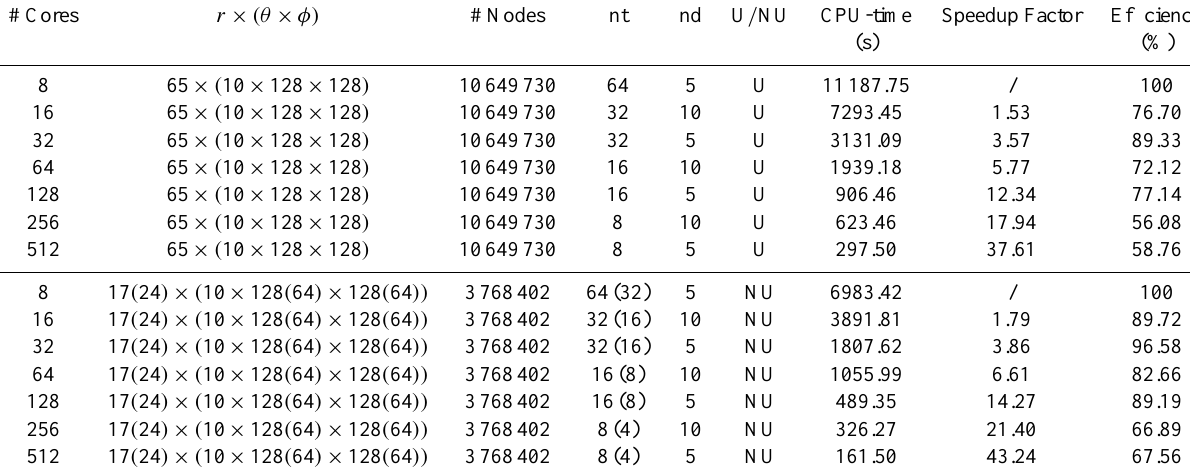
Table 2. CPU-time for different grid configurations across a range of cores, with the domain decomposed according to nt – the number of grid intervals along the edge of a local subdomain, and nd – the number of diamonds mapped to a local process. The speedup factor is calculated relative to the 8-core simulation (the problem was too large to run on a single core), whilst the efficiency is calculated from the following formula: speedup factor / (# cores / 8). Note that whilst we only present the results for cases at mt = 128, the observed trends are consistent across different problem sizes.